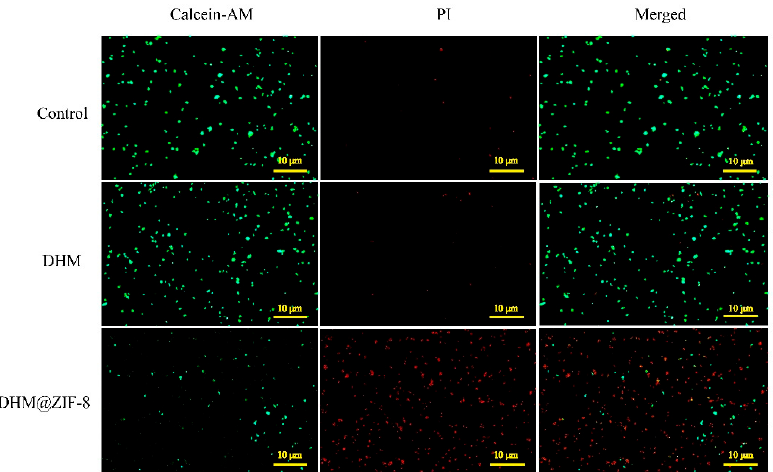
Figure 5. Fluorescence microscopy images were used after processing with DHM or DHM@ZIF-8, and all the images were scaled to 10 µm. Living cells were represented by green fluorescence and dead cells were represented by red fluorescence.